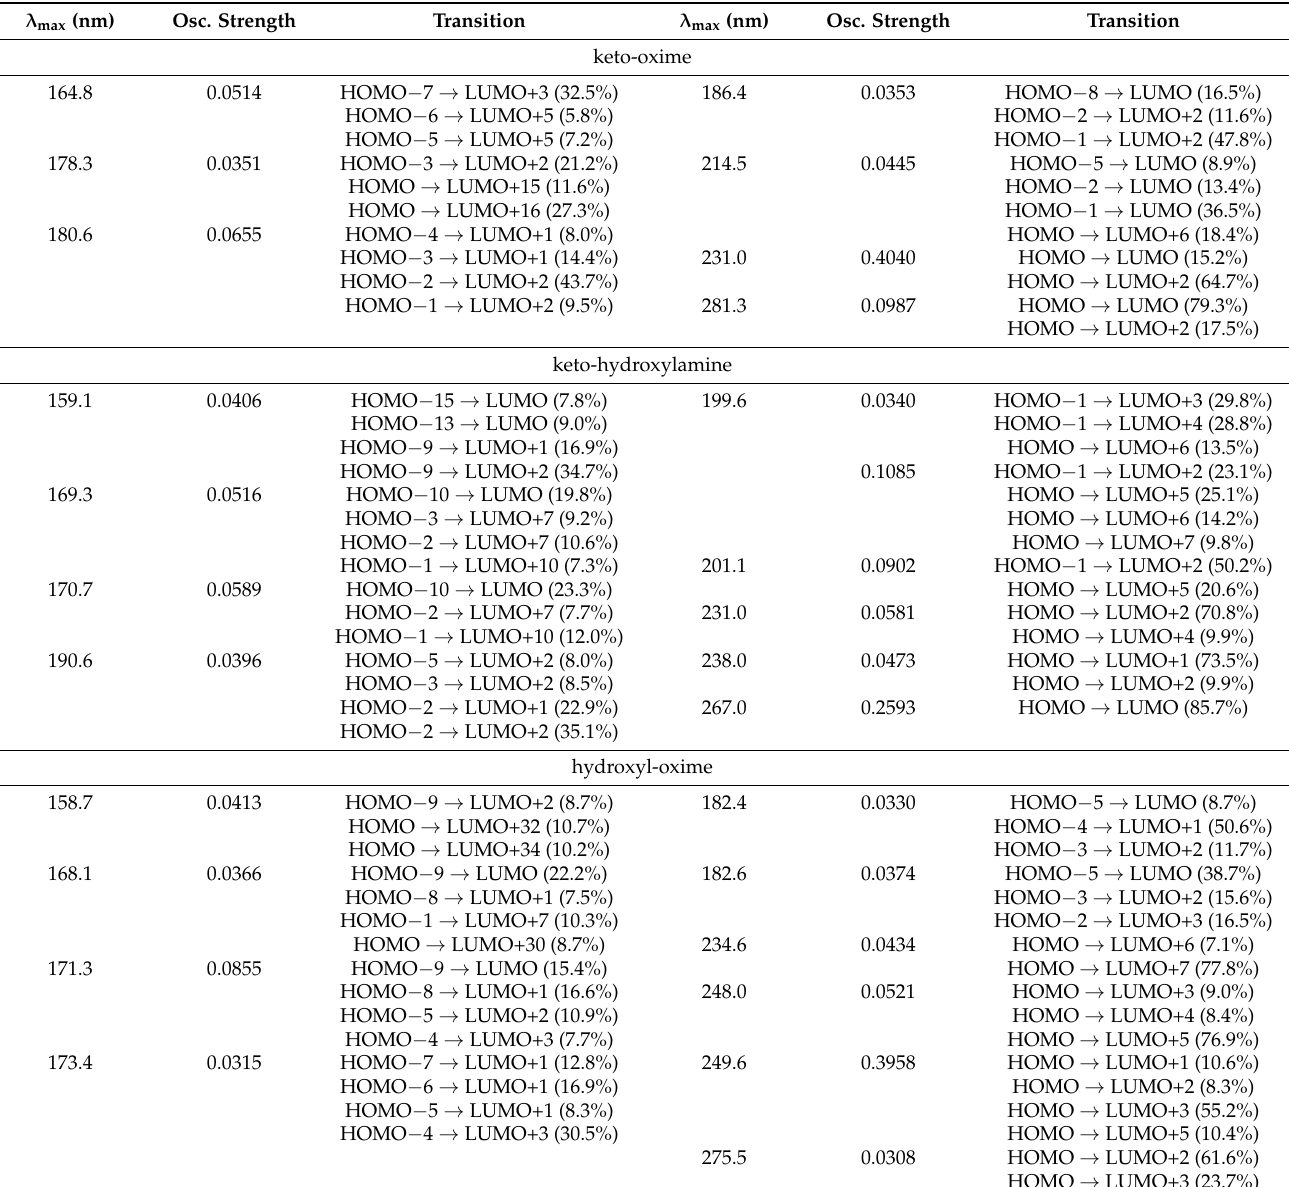
Table 6. Values of the calculated UV-vis spectra (Figure 6) for the optimized structures of the keto- oxime, keto-hydroxylamine, and hydroxyl-oxime tautomers of molnupiravir, obtained by using the TD-DFT/B3LYP/6-311++G(d,p)